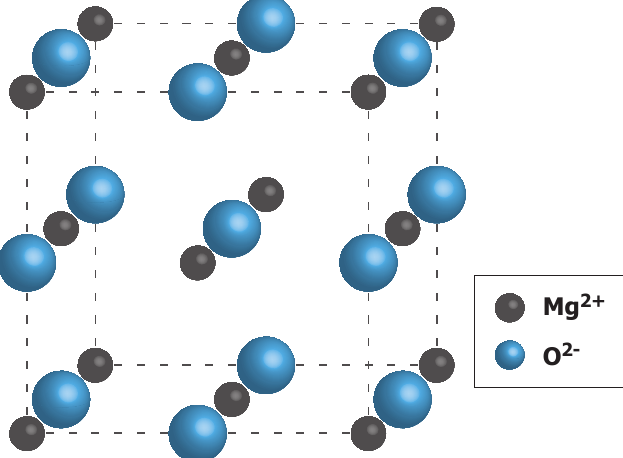
Figure 1. Structure of magnesium oxide crystal (Redrawn and adapted from